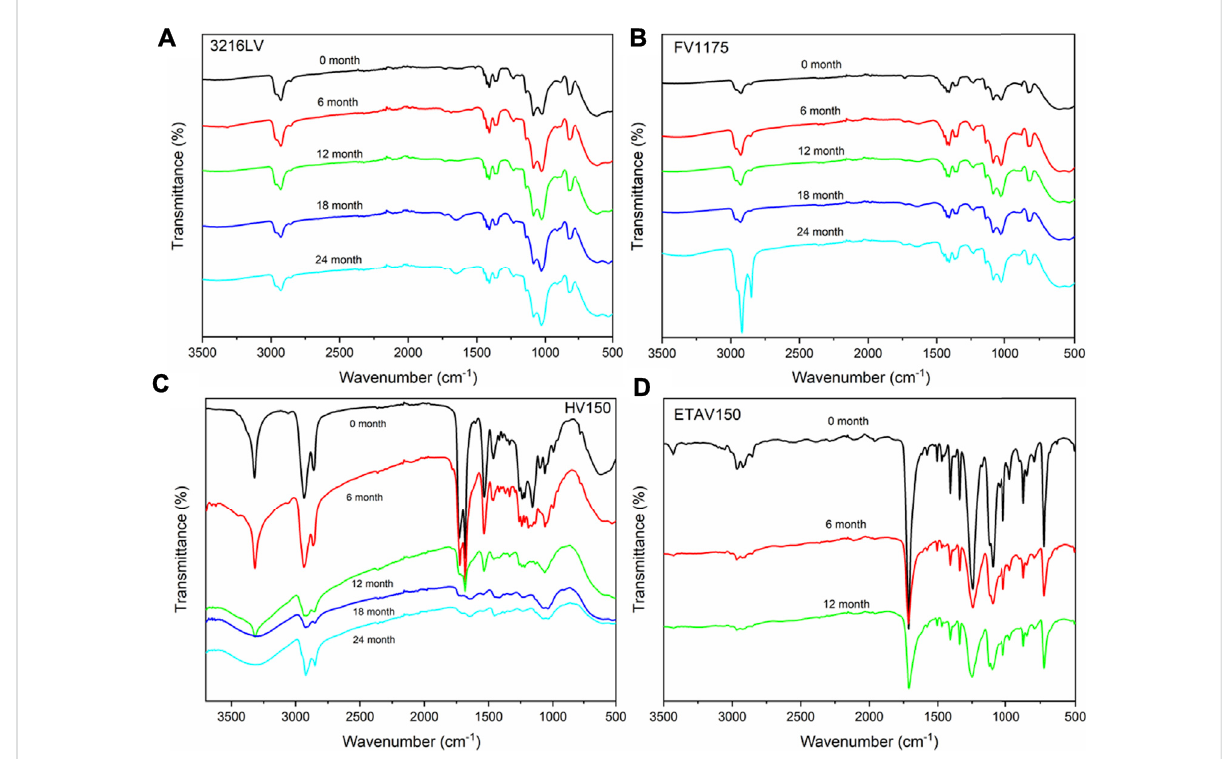
FIGURE 8 FT-IR spectra of (A) 3216LV, (B) FV1175, (C) HV150, and (D) ETAV150 before and after natural